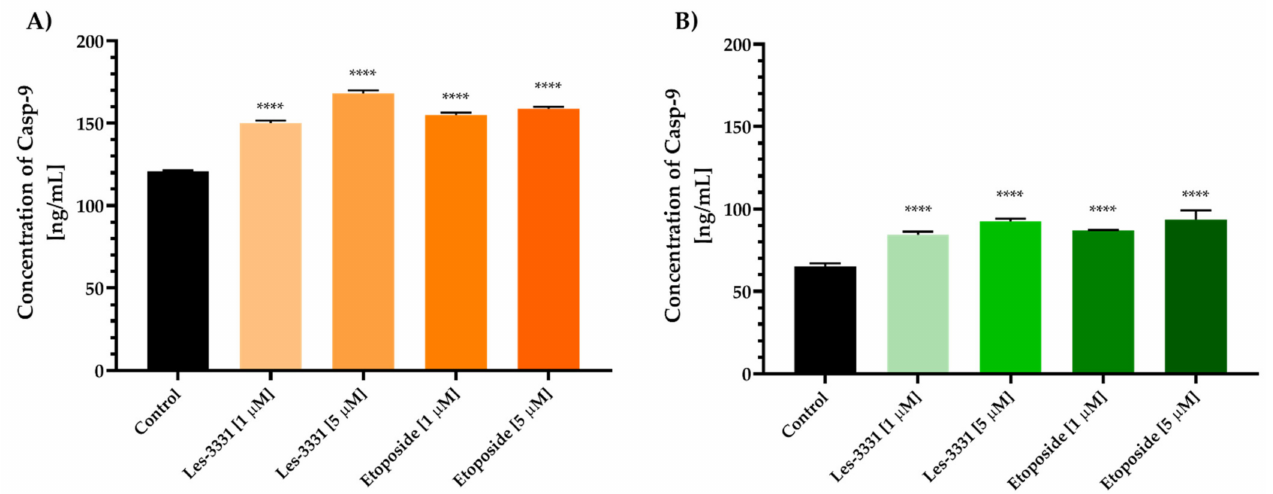
Figure 6. The concentration of caspase-9 in MCF-7 ( A ) and MDA-MB-231 ( B ) human breast cancer cells after 24 h incubation Les-3331 and reference drug (etoposide) at 1 µ M and 5 µ M concentration. Mean ± SD from three independent experiments performed in duplicate is presented. Statisti- cal significance was calculated using one-way ANOVA with Bonferroni multiple comparison test. Differences were considered statistically significant at **** ( p ≤